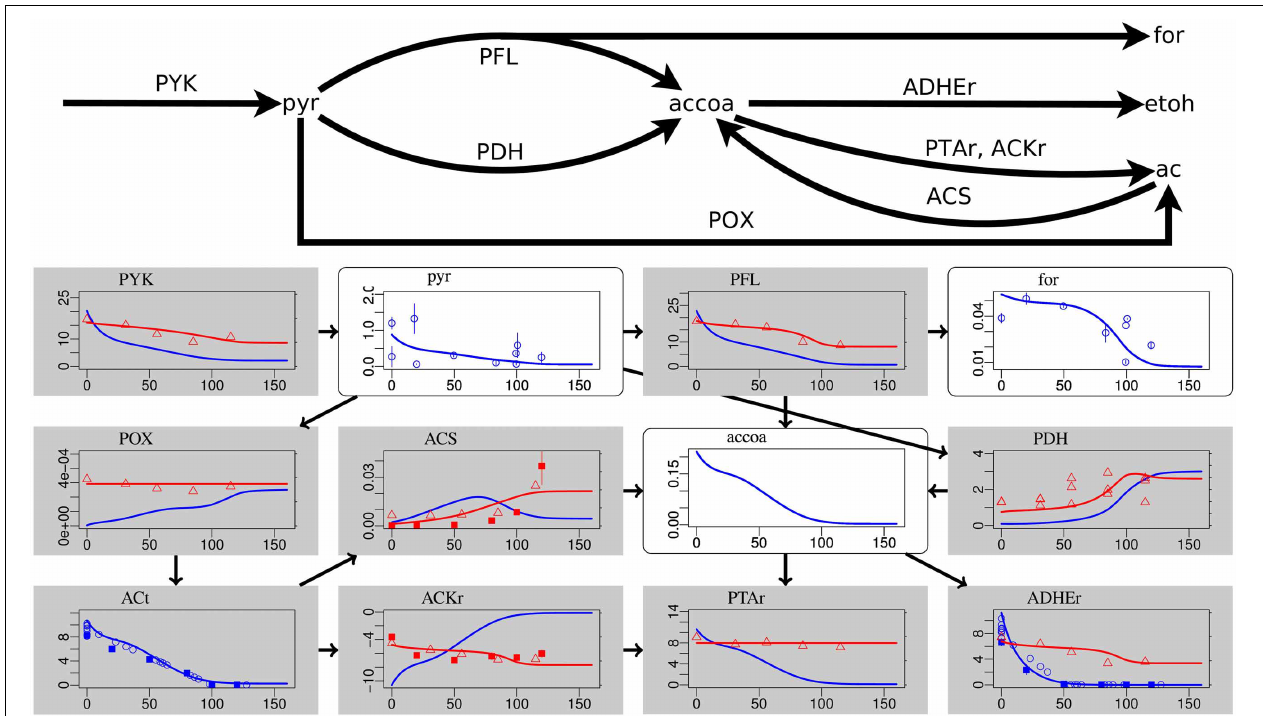
FIGURE 1 | Steady-state simulation results of the fermentation pathways in comparison to measurement data. The abscissa is aerobiosis in percent. White boxes represent metabolites. The ordinate is in nmol/g. Blue lines and circles show simulation and measurement data, respectively. The error bars show the technical standard deviation. Gray boxes represent reactions. The blue lines show the reaction flux in mmol/g/h. Blue symbols show flux data computed from the steady state concentration of extracellular concentrations. Different symbols indicate that the data were measured in different laboratories. The red lines show gene expression in arbitrary units. If